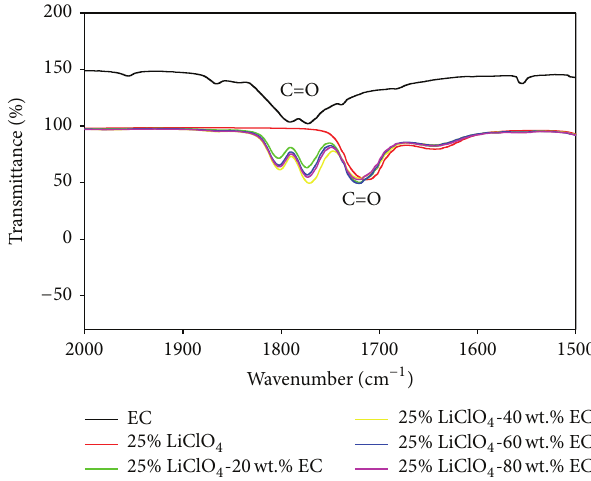
Figure 5: FTIR spectra of PGMA-25 wt.% LiClO 4 -EC based polymer electrolyte as a function of EC in the wavenumber region 2000–1500 cm −1